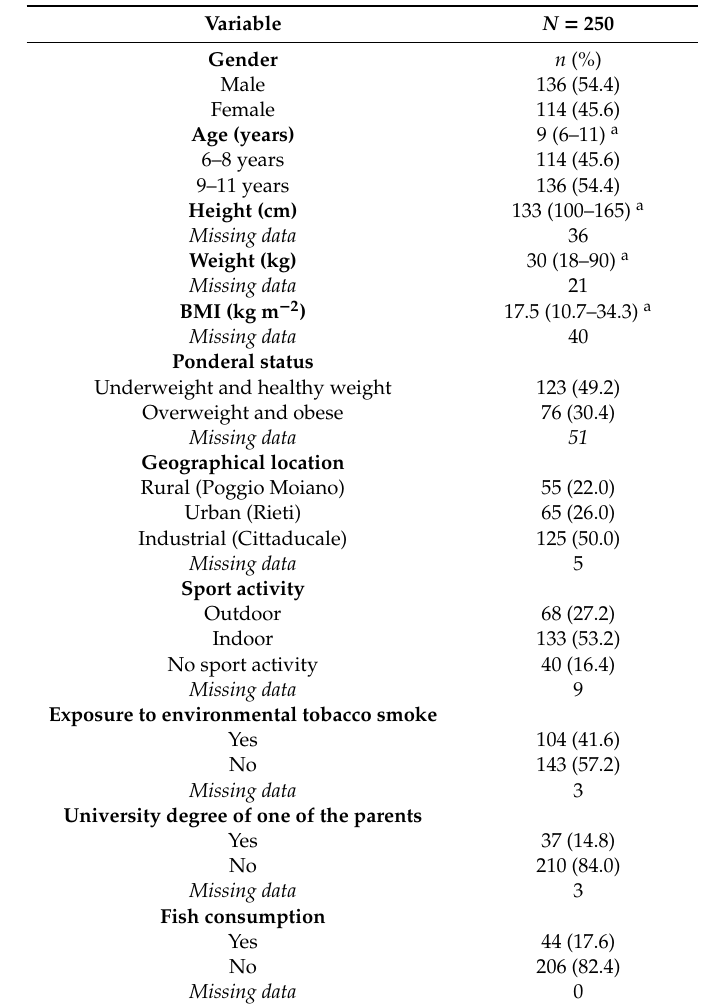
Table 1. Studied population